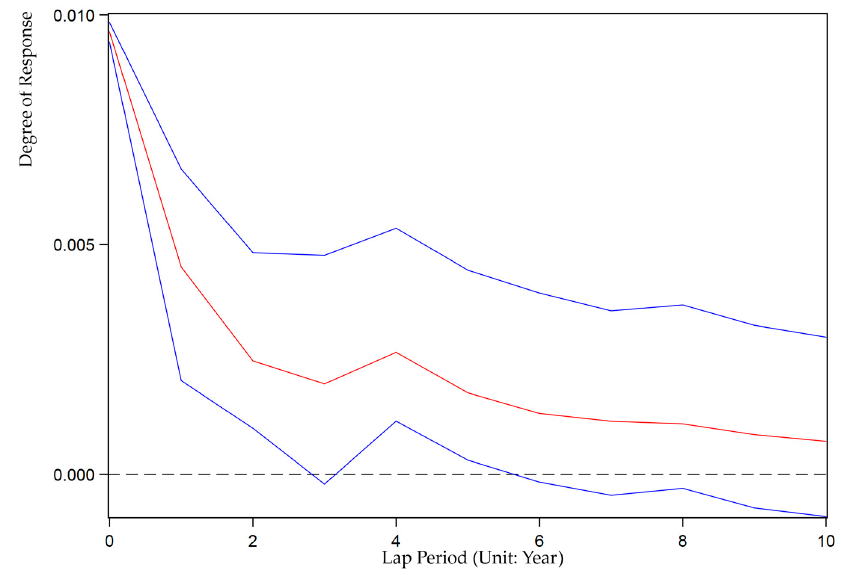
Figure 2. Impulse response of ULDI to ULDI.